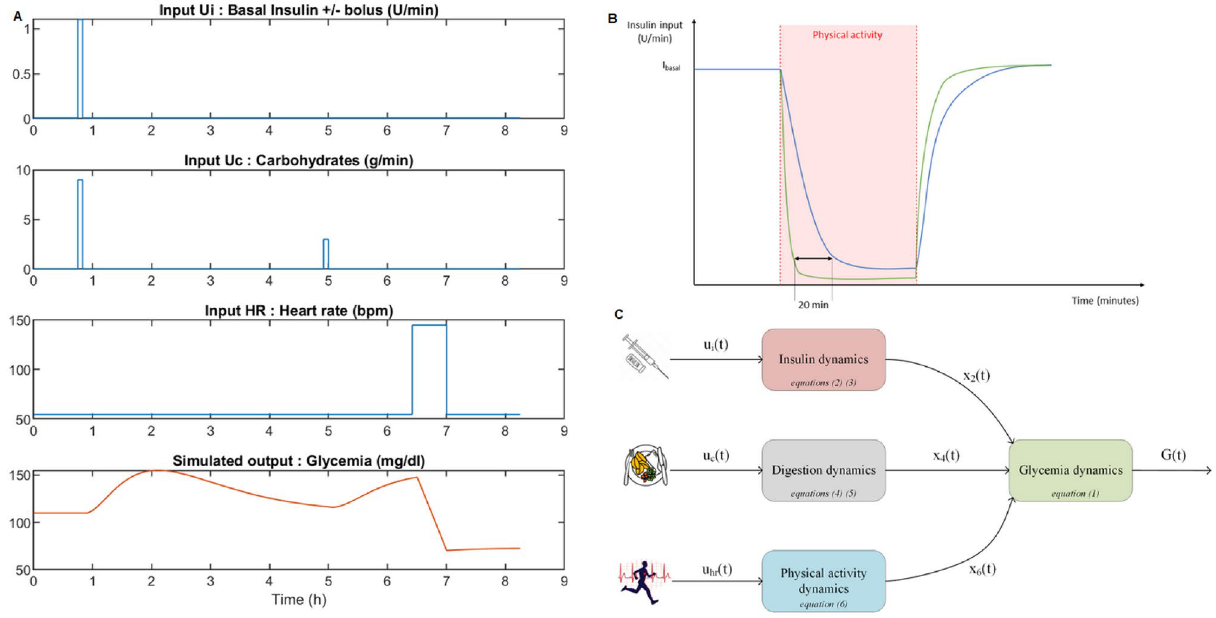
Figure 2. The extended FIT model and control law behaviour in the simulation. ( A ) Simulation scenario used to assess the extended FIT model behaviour in reaction to different disturbances. U i stands for the insulin input flow and is in [U/min], U c corresponds to the ingested carbohydrates’ flow in [g/min] and U hr is the heart rate in [beats/min] or [bpm]. ( B ) Diagram highlighting the benefits of a control law with a physical activity variable (in green) and with only a glycaemic regulation term (in blue). In response to aerobic activity, the use of data